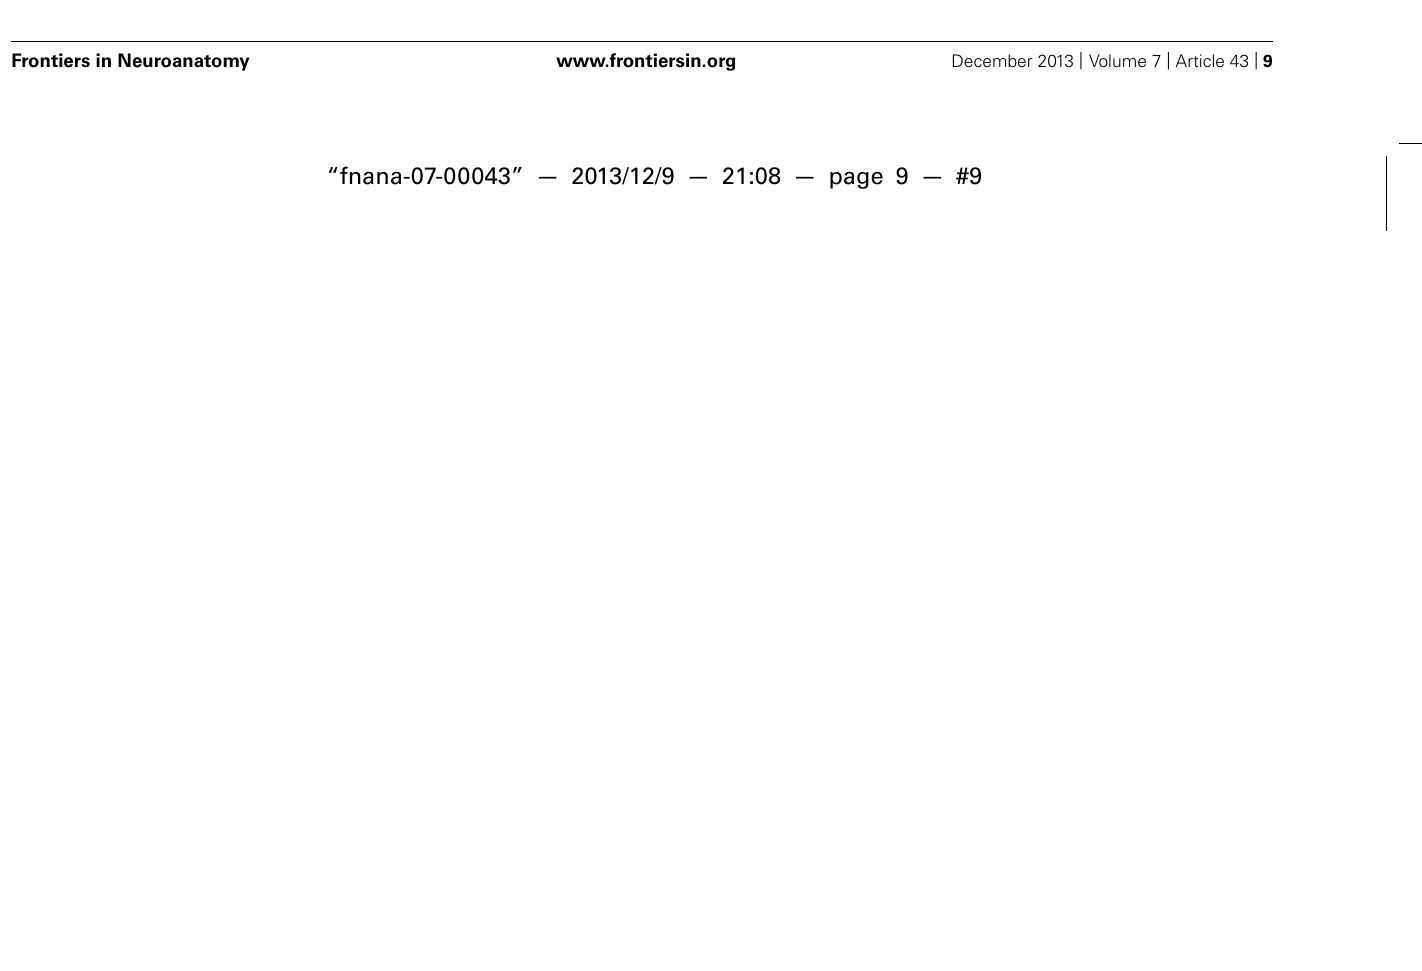
(ac; Figure 4B3 ), the ventromedial LPO at the level of optic chiasm ( Figure 4B4 ), and the ventral LHa. Within the LHa, varicosities were sparsely distributed and showed small round and ellipse ( Figure 6D ). However, after ventral AcbSh injection, hrGFP-IR axons were found in the dorsal part of LPO at the level of optic chiasm ( Figure 4C3 ), and the dorsolateral portion of LHa ( Figure 4C4 ). The mean diameter (1.575 μ m) of the